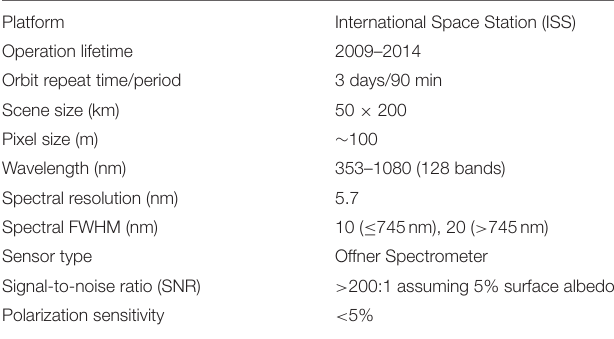
TABLE 1 | HICO sensor and data